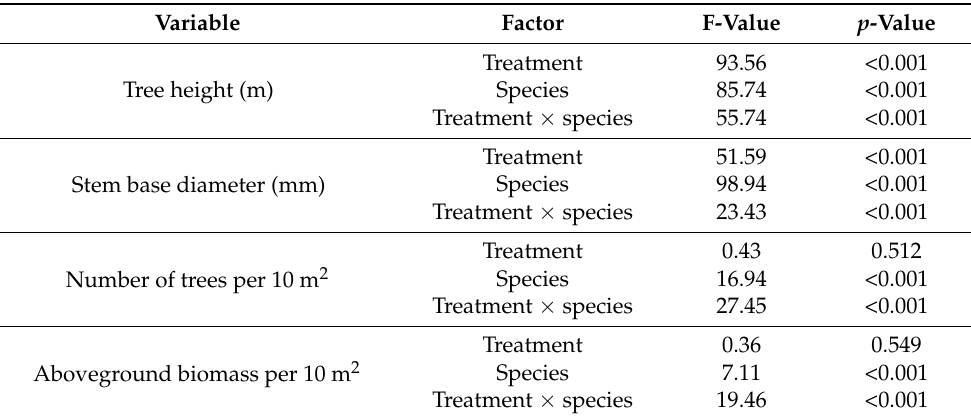
Table 3. F values and p values from two-way ANOVA for basic stand characteristics considering treatment (unfenced vs. fenced) and tree species (includes Norway spruce, silver birch, common rowan, and others) and their combined effect on the stand characteristics.